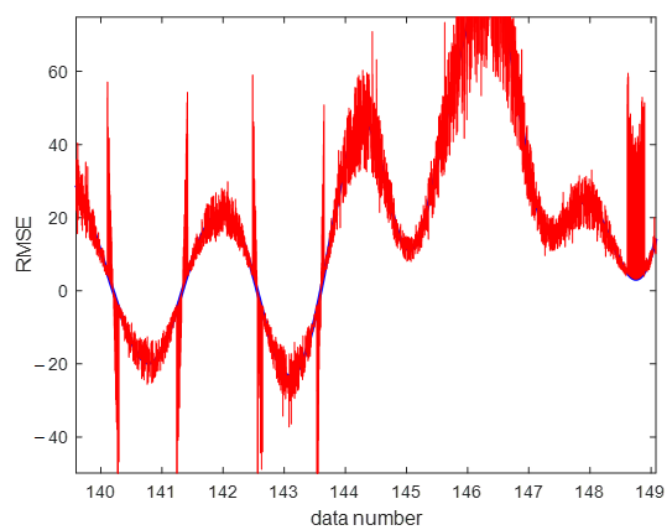
Figure 15. RMSE of the model.